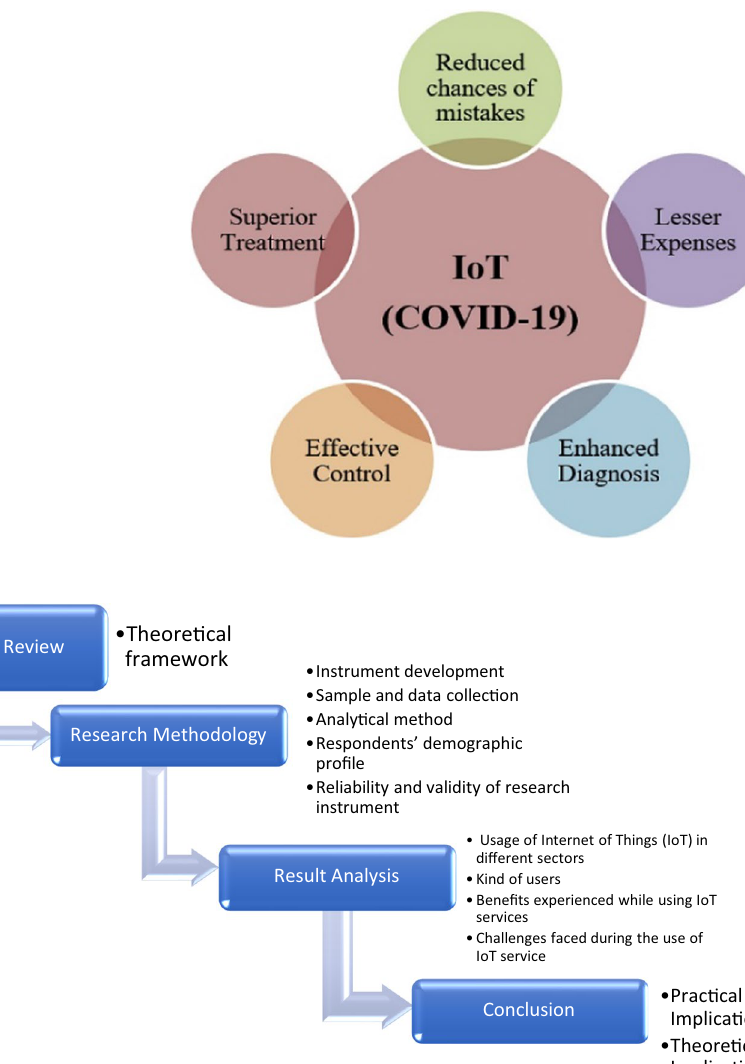
Fig. 3 Major merits of using IoT [38]